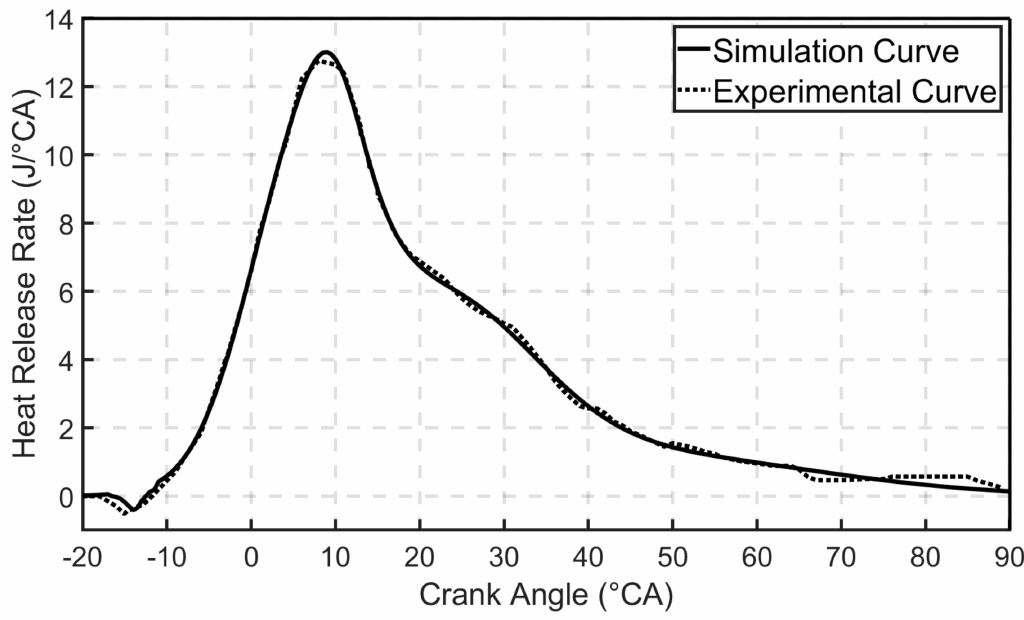
Figure A3. Comparison between heat release curves (medium load).